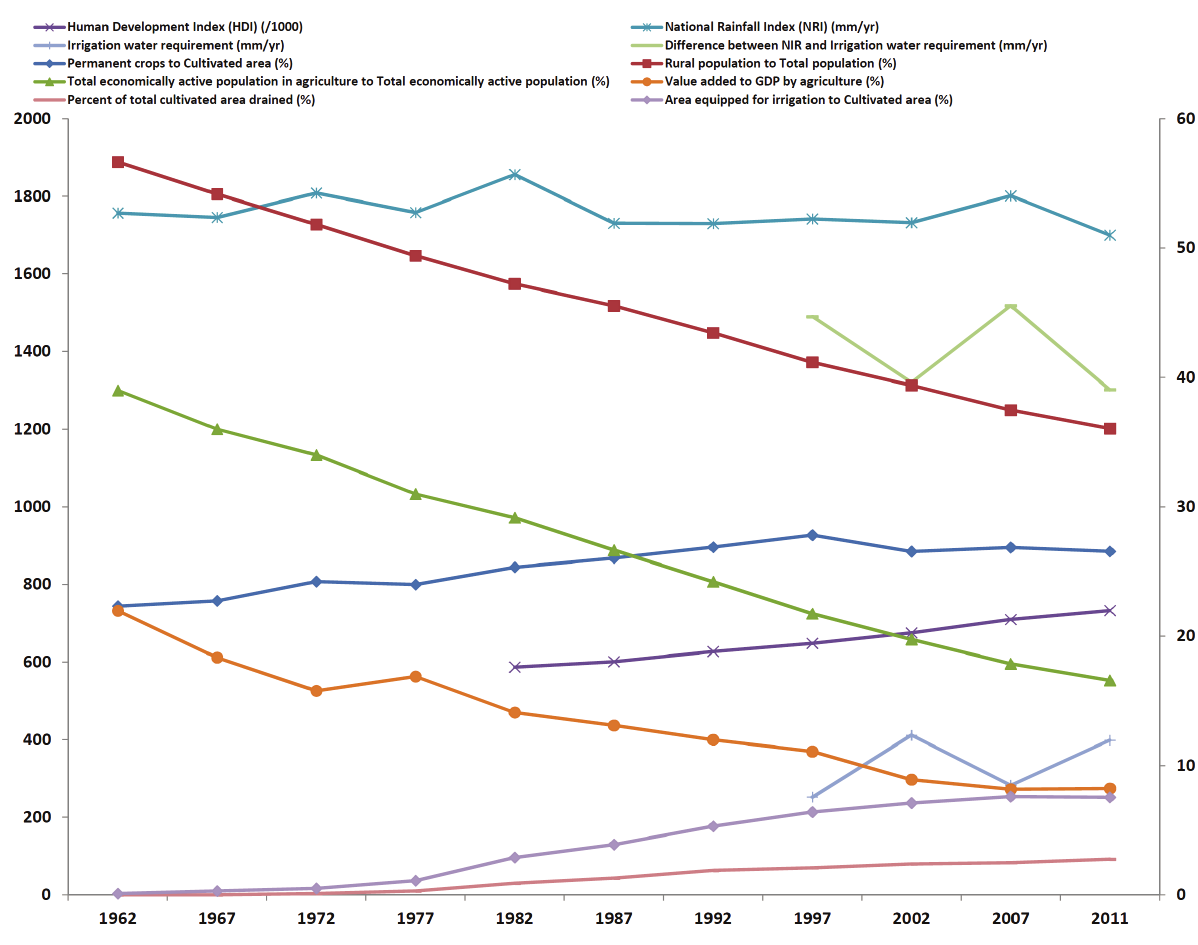
Figure 14: Variations of the main indexes for Americas in the past half of century, the left axis is belong to HDI, NRI, irrigation water require- ment, and difference between NRI and irrigation water requirement and the right axis is belong to permanent crops to cultivated area, rural population to total population, total economically active population in agriculture to total economically active population, value added to GDP by agriculture, percent of total cultivated area drained, and area equipped for irrigation to cultivated area (value of the HDI is not availa- ble before 1982 and values of irrigation water requirement and difference between NRI and irrigation water requirement are not available before